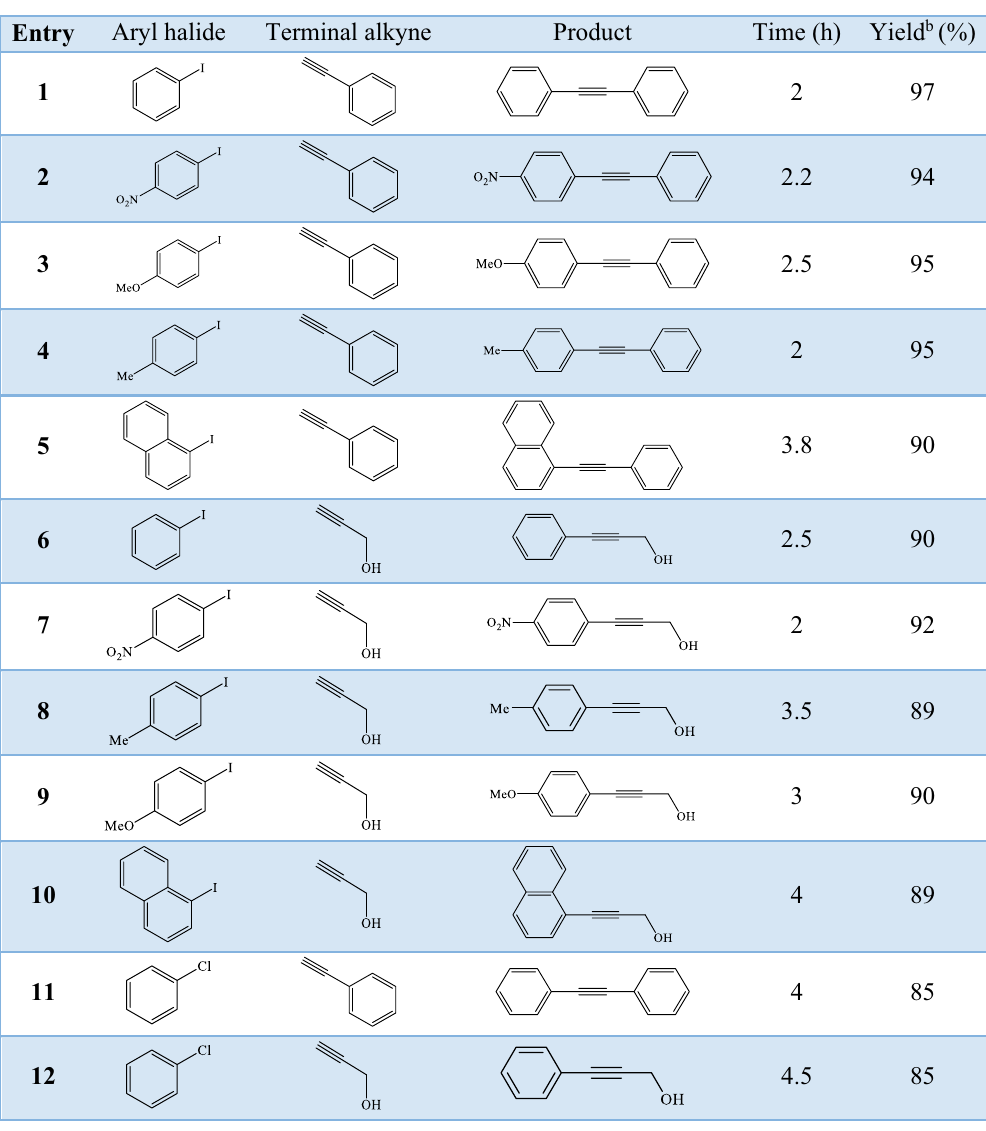
Table 2. Pd@Hal-DAB-PC catalyzed Sonogashira reaction of various halides with terminal alkynes a . a